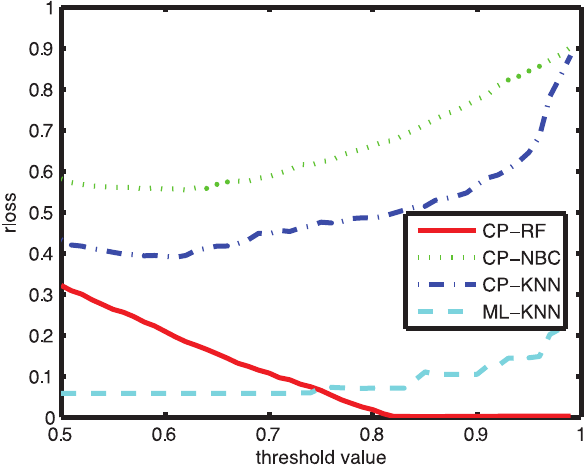
Figure 7. Comparison of ranking loss with different thresholds.